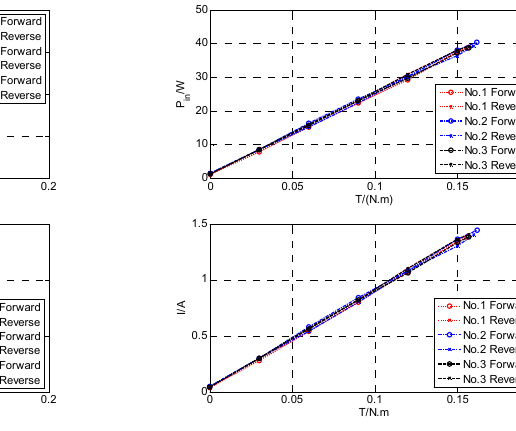
Figure 19. Experimental data of prototypes.